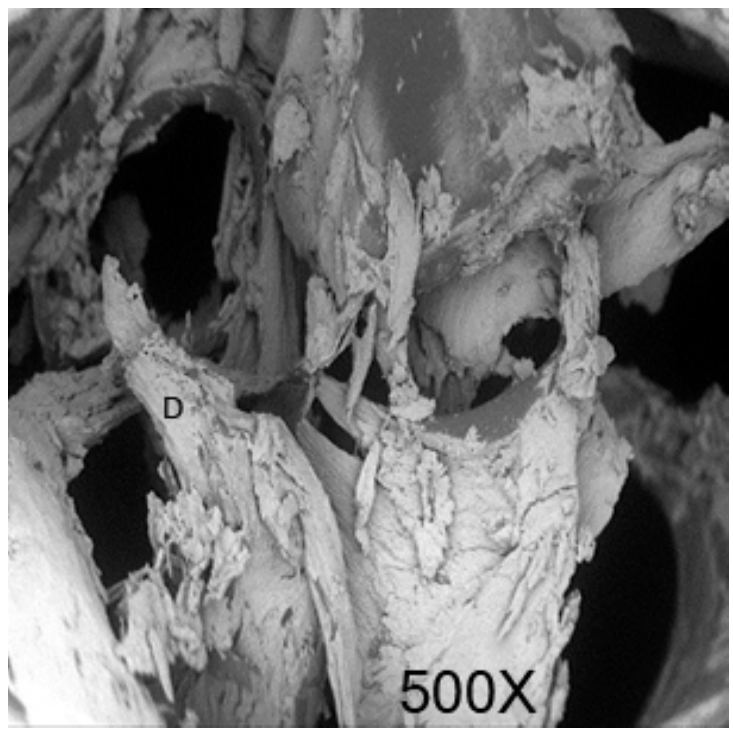
Figure 2. Round tungsten carbide bur sample surface (D—debris).